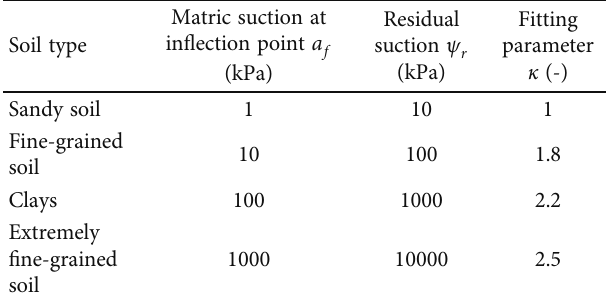
Table 2: Parameters for water retention behavior.